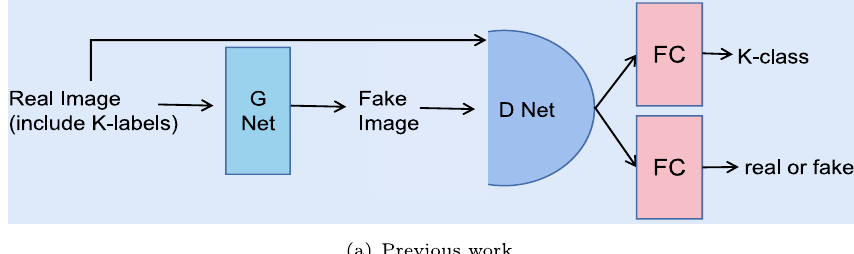
Fig. 1 The previous and proposed architecture, all com- ponents are parameterized by neural networks in which layers remain trainable throughout the training